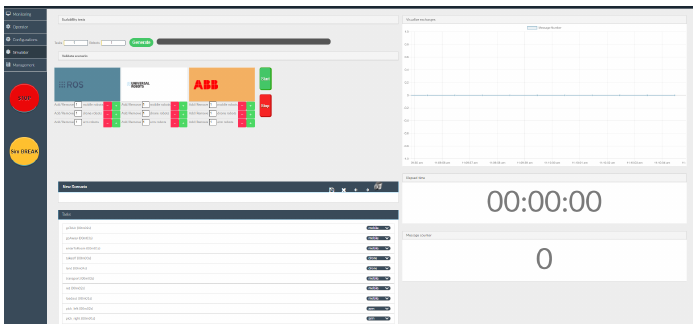
Figure 10. Simulator